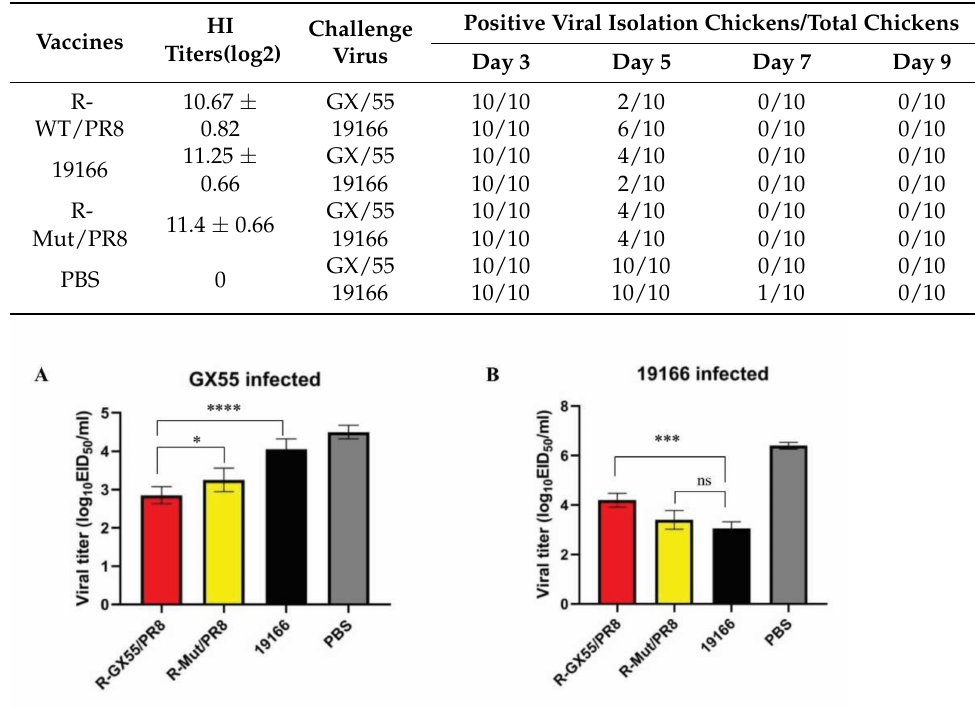
Table 1. Virus shedding of trachea swabs in vaccinated chickens challenged by H9N2 virus.